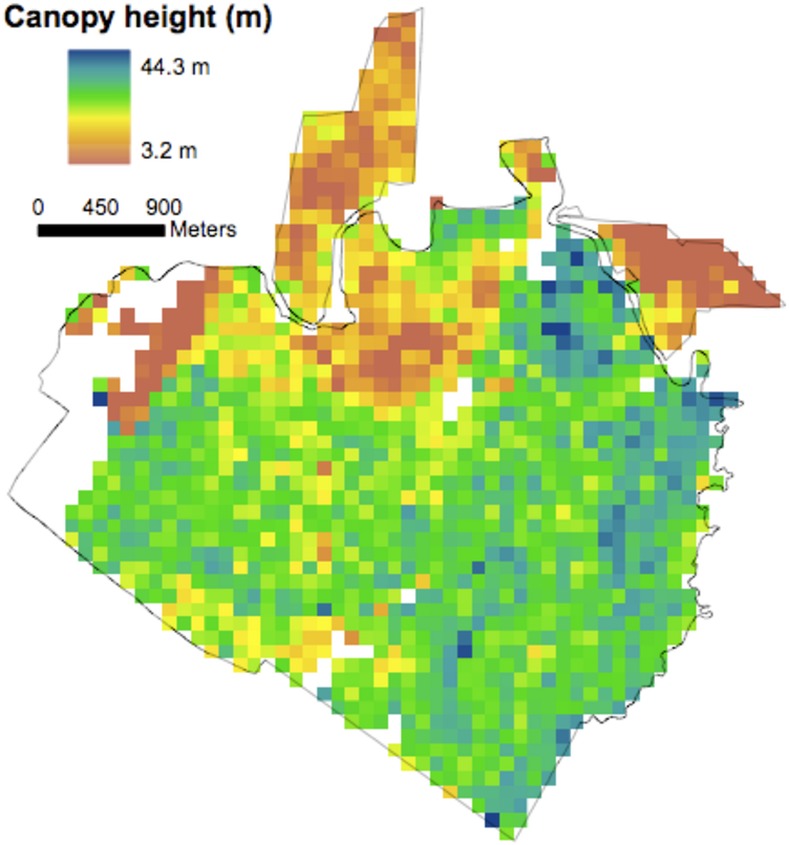
LVIS mean CTH 1998 at 1 ha.[9,20].